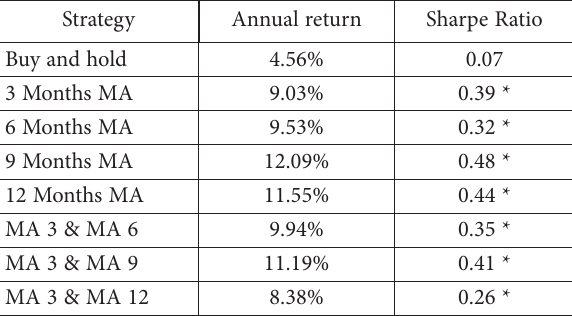
Table 2. Performance of buy-and-hold strategy compared to technical trading strategy based on Moving Averages (MA) Strategy Annual return Sharpe Ratio Buy and